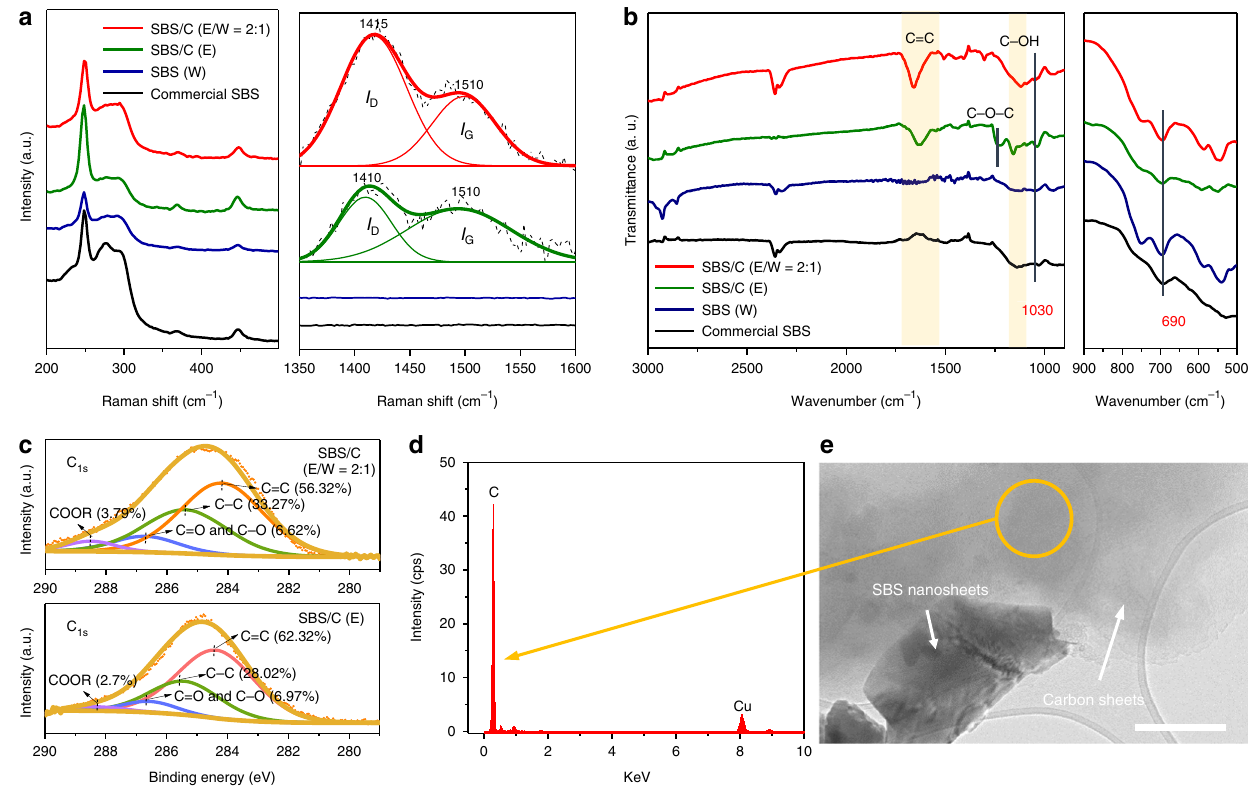
Fig. 3 Characterization of carbon sheets. a Raman spectra of exfoliated products in different solvents, SBS (W), SBS/C (E), and SBS/C (E/W = 2:1) compared with commercial SBS, indicating the generation of amorphous carbon during exfoliation in ethanol-containing solvents. b FTIR spectra of commercial SBS, SBS (W), SBS/C (E) and SBS/C (E/W = 2:1). c XPS analysis of C 1s peaks of SBS/C (E/W = 2:1) and SBS/C (E). d EDS spectrum of the indicated region in ( e ), indicating the carbon sheets. e TEM image of exfoliated SBS/C composite (E/W = 2:1). Scale bar: 200 nm ( e